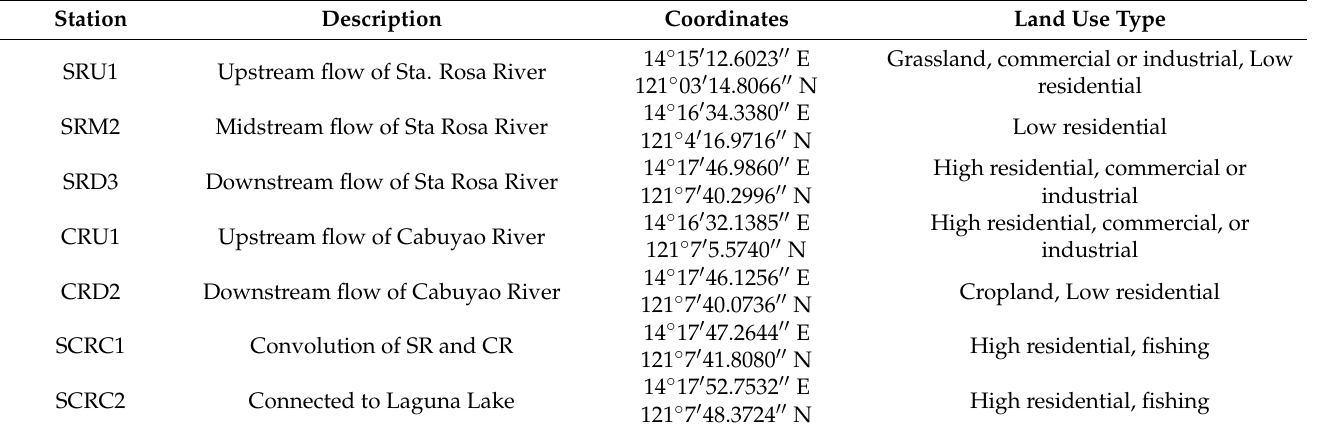
Table 2. Description and land use of the seven sampling stations along with the